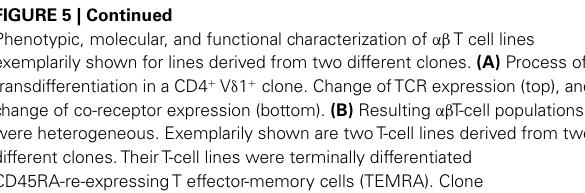
K1-V δ 1 + -derived αβ T cells were CD8 αβ + and did not express CD28 and CD25. Clone P7-V δ 1 + derived αβ T cells were CD4 + , lacked CD28 but expressed CD25 int . (C) Molecular analysis ofTCR chain δ -, γ -, β -, and α -transcripts in two CD4 + V δ 1 + clones (K1-V δ 1 + and P7-V δ 1 + ) and two of the derived αβ T-cell lines